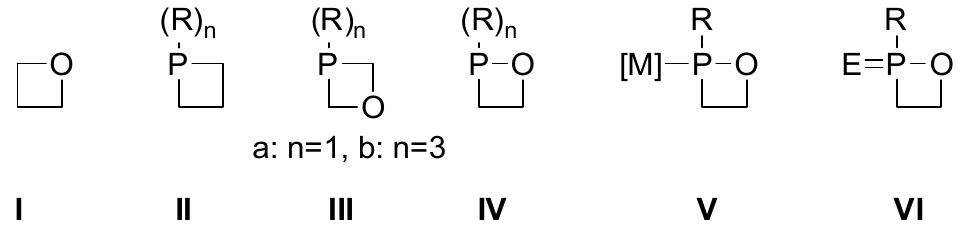
Figure 1. Oxetane ( I ), phosphetanes ( σ 3 λ 3 IIa , σ 5 λ 5 IIb ), 1,3-oxaphosphetanes ( σ 3 λ 3 IIIa , σ 5 λ 5 IIIb ), 1,2-oxaphosphetanes ( σ 3 λ 3 IVa , σ 5 λ 5 IVb ), 1,2 σ 3 λ 3 -oxaphosphetane metal complexes ( V ), and 1,2 σ 4 λ 5 -oxaphosphetanes ( VI ).